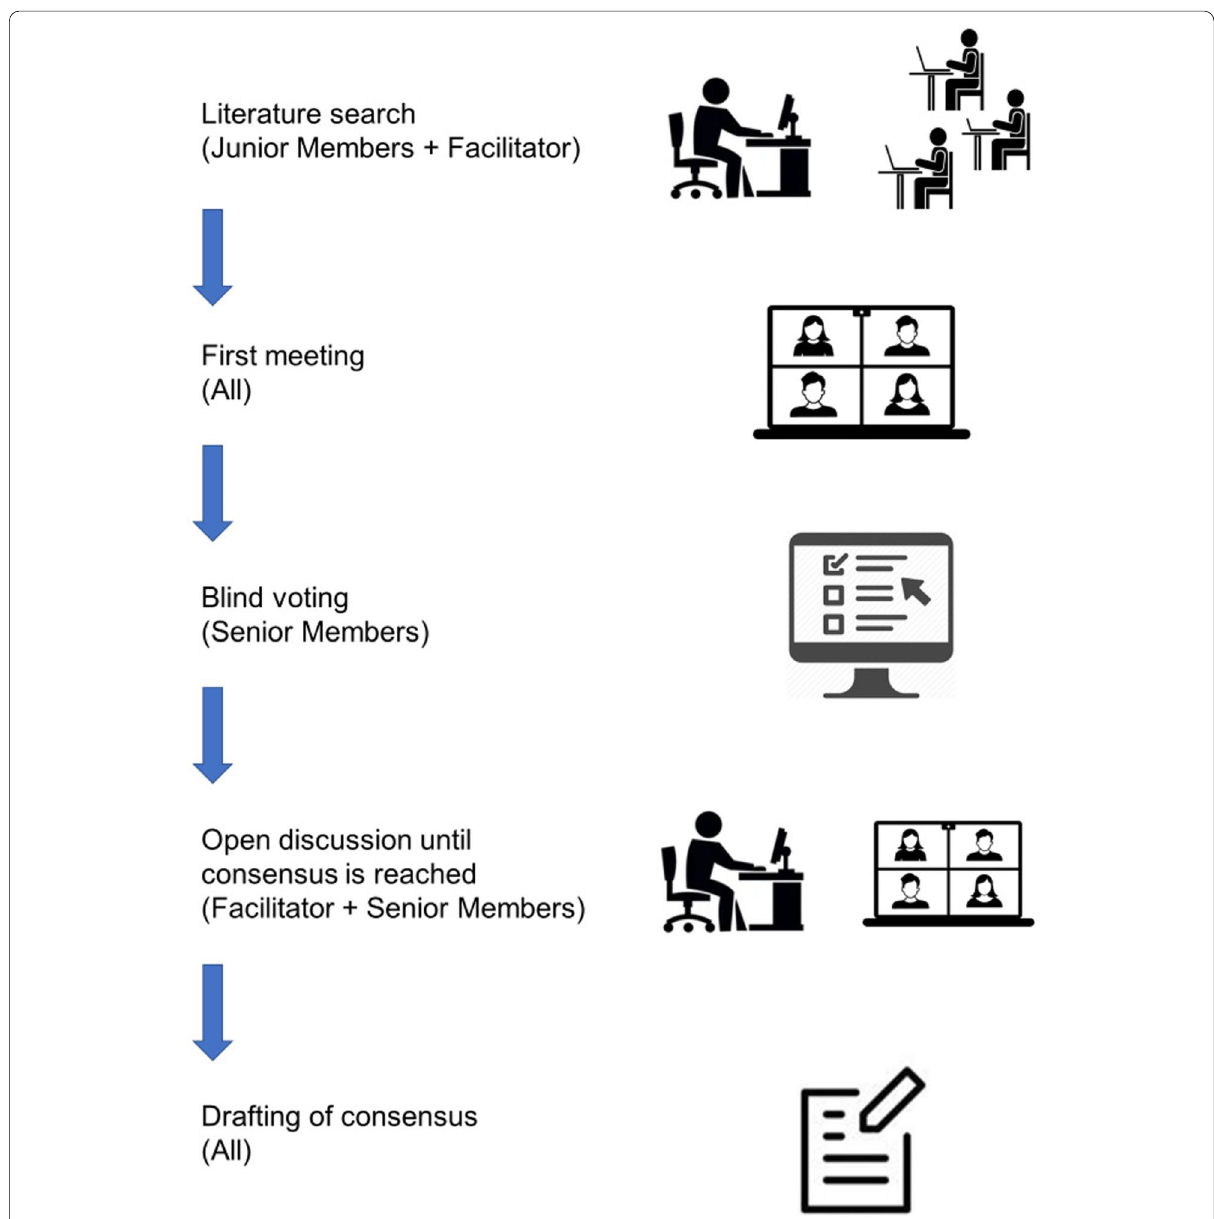
7. Pain freedom within 2 hours of early versus late treat- ment with triptans . Pain freedom: 28.0–67.0% if treated early (variously defined as within 1 hour from onset, 4 hours from onset, or when the pain is mild) vs 27.0–55.0% if treated later.